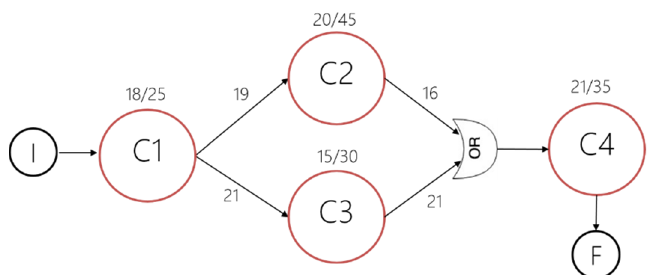
Figure 1. Example of a competence map. Nodes are skills named from C1 to C4, with I and F as the initial and final nodes respectively. Each of them has minimum and maximum thresholds, shown as numbers separated as at the top of each competence. The arrows between nodes indicate precedence between competences, which have an associated number that represents their unlocking thresholds. The OR is a sort of logic gate to mark the dependency.